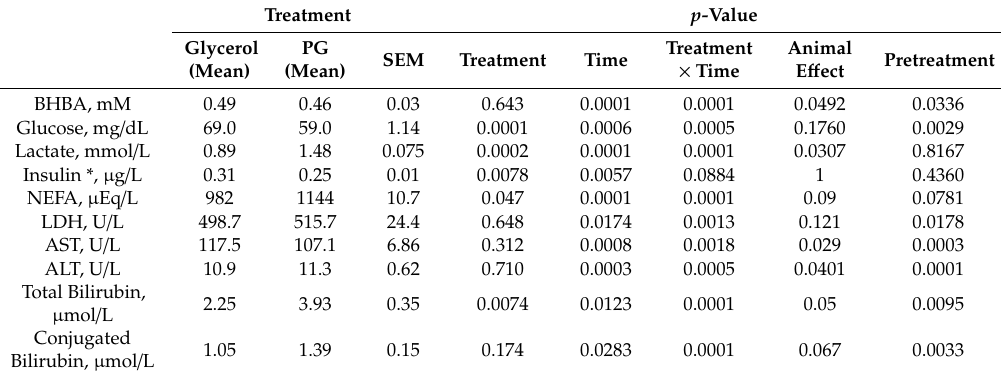
Table 1. E ff ects of intravenous infusion of glycerol and propylene glycol